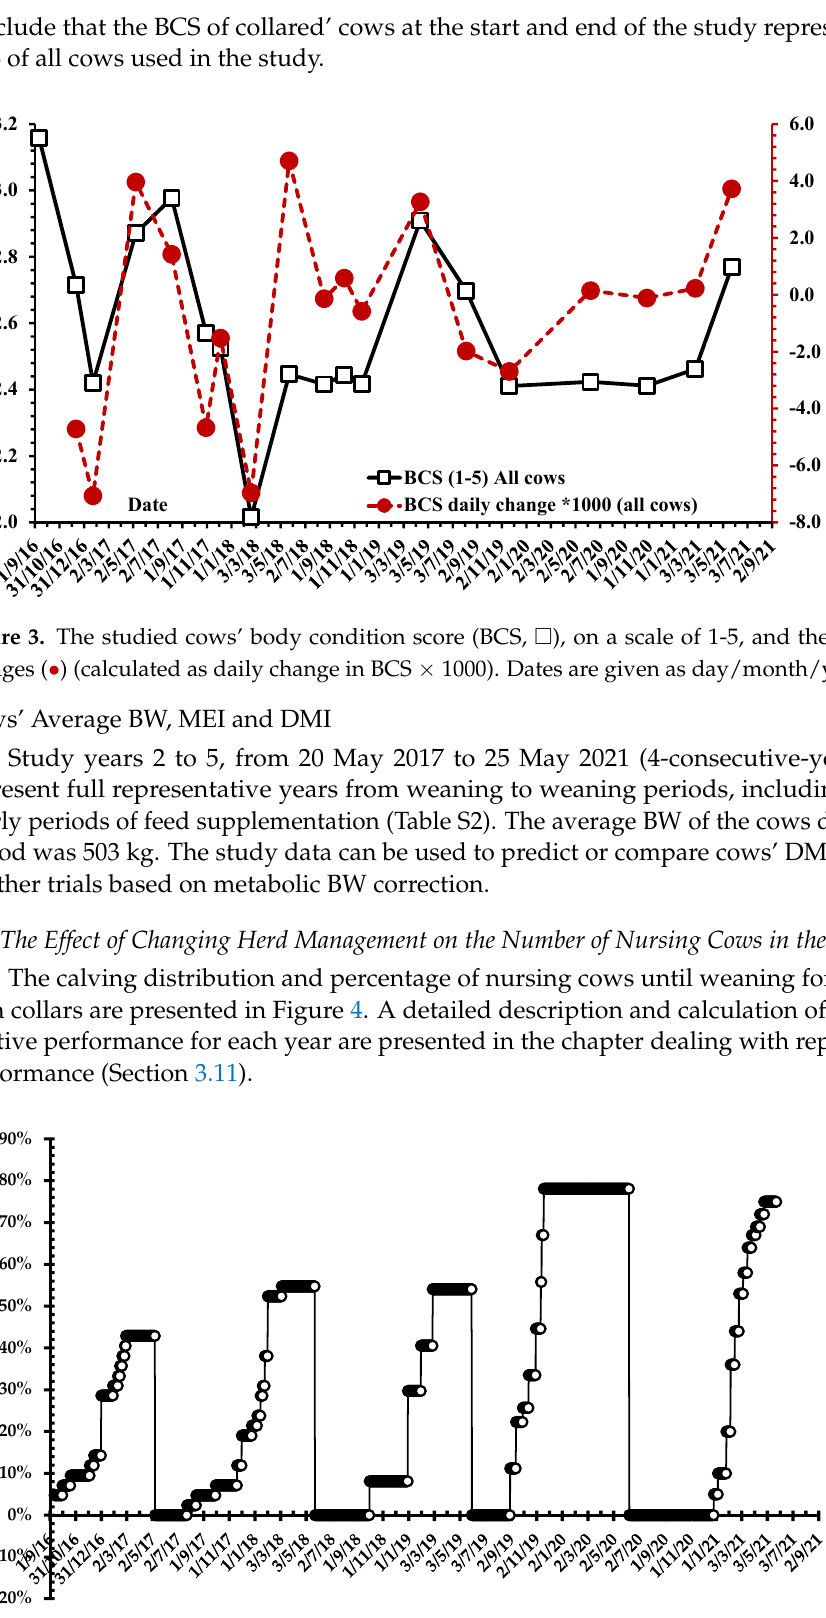
Figure 4. Percentage of nursing cows during the study, calculated for collared’ cows. Dates are given as day/month/year.